Question: Write a caption explaining this figure to a reader.
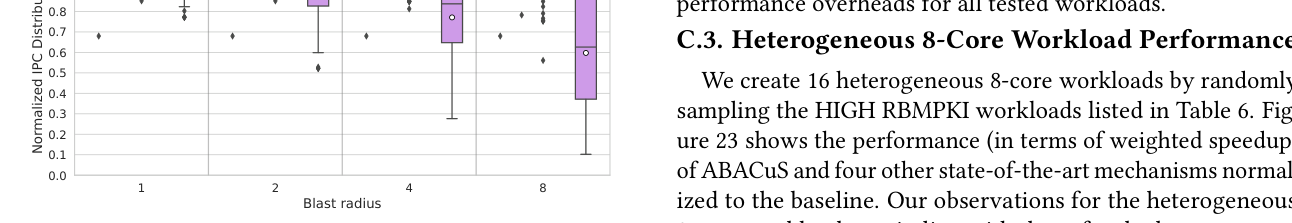
Answer: shows the performance of ABACuS and four state- of-the-art mechanisms’ performance overheads over four blast radius (see §6) values normalized to baseline (for NRH = 1000). From Fig. 21, we make two key observations. First, ABACuS has relatively small 0.58%, 0.66%, 0.85%, and 1.28% average per- formance overheads for blast radius = 1, 2, 4, and 8, respectively. Second, as blast radius increases, all mitigation mechanisms ex- cept REGA induce increasing performance overheads (at NRH = 1000). This is because higher blast radii necessitate more vic- tim row refreshes, i.e., more activate and precharge commands